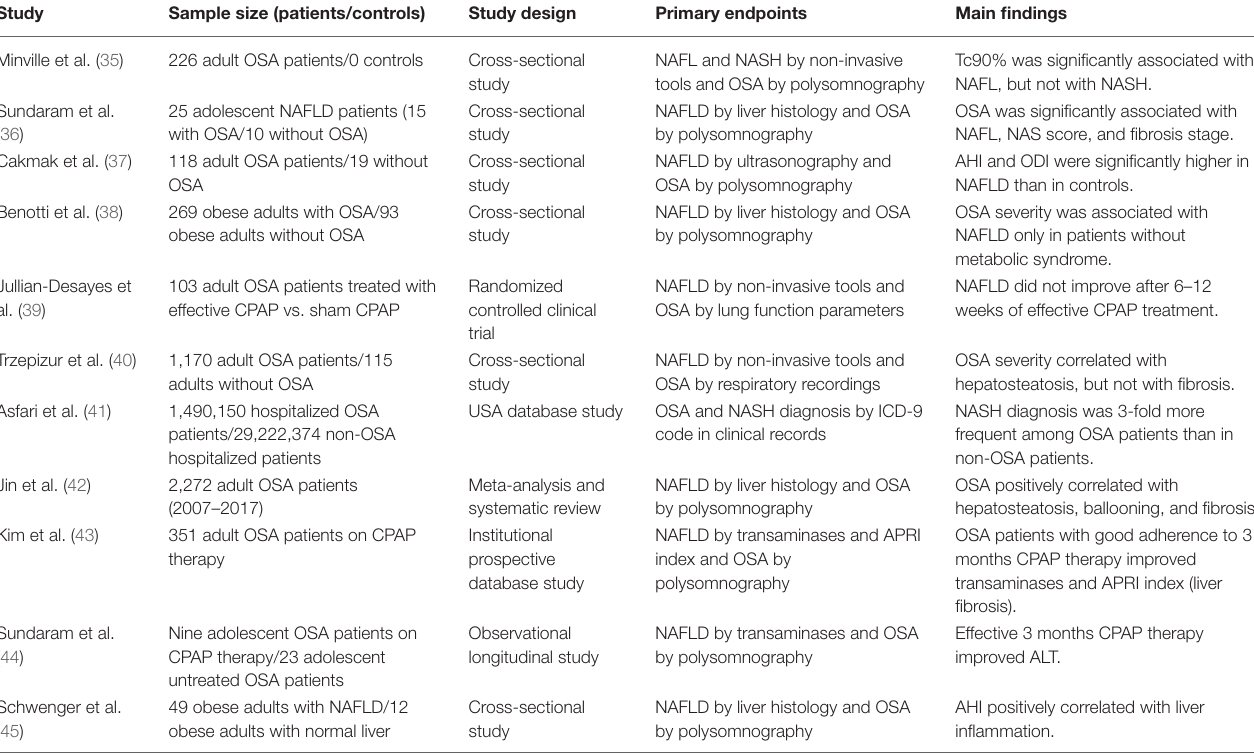
TABLE 1 | Principal clinical studies examining the impact of OSA on